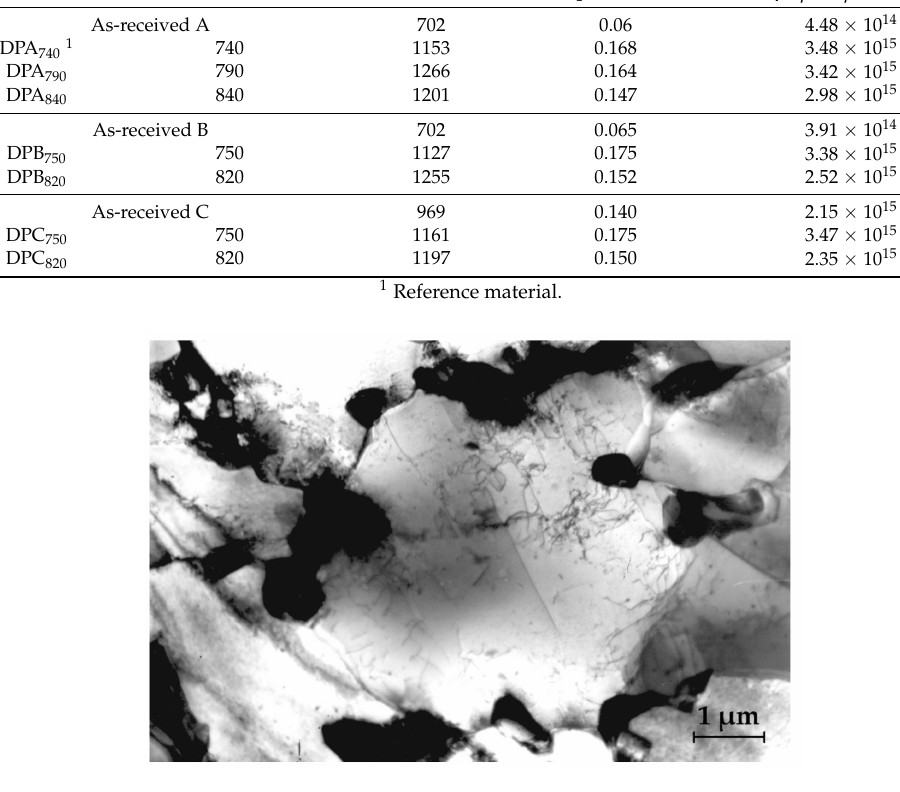
Figure 15. The dislocation density in the ferrite grain near the martensitic